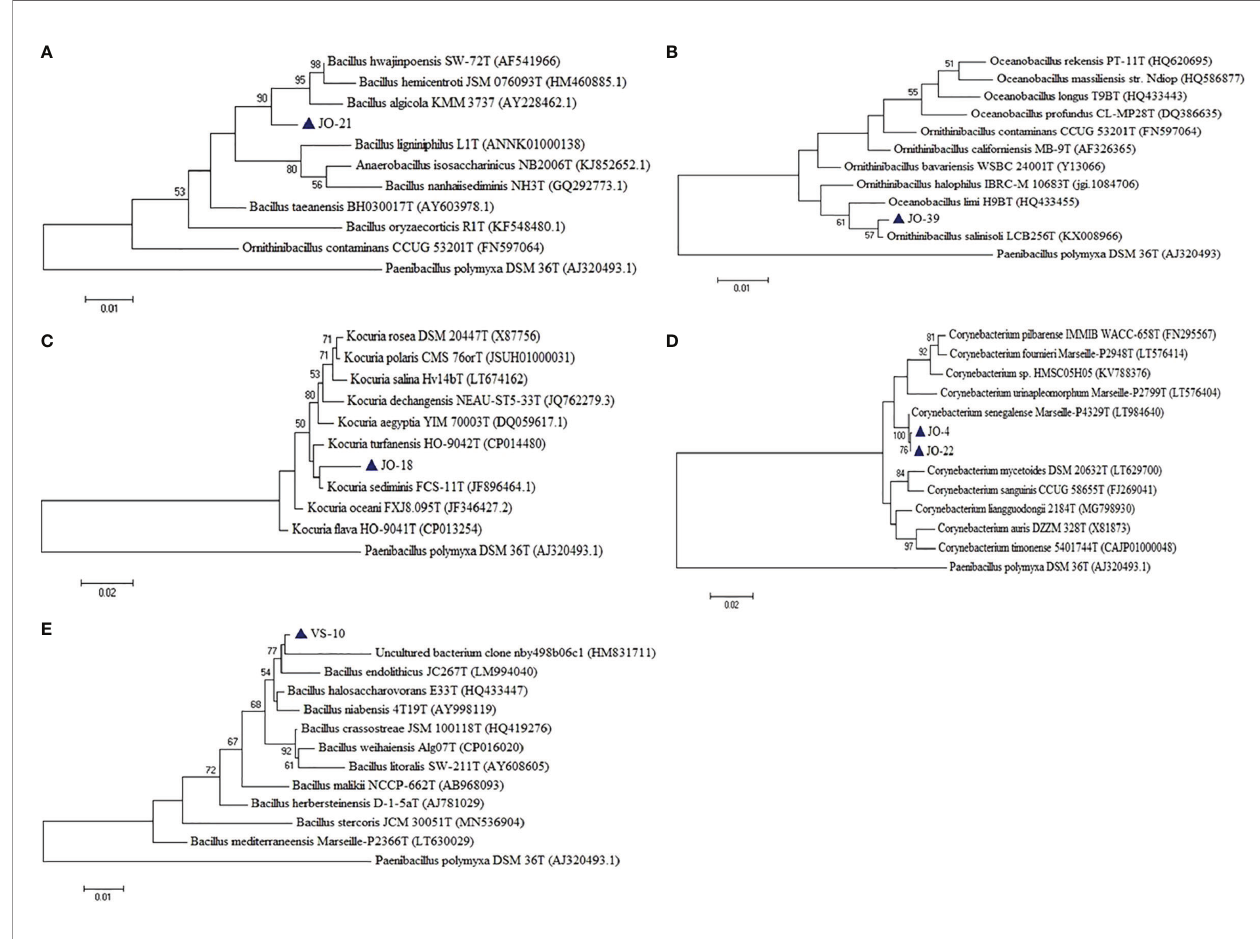
FIGURE 9 | Phylogenetic tree constructed using 16S rRNA gene sequences of putative novel taxa (A) JO-21, (B) JO-39, (C) JO-18 (D) JO-4, and JO-22, (E) VS- 10, and some of their closest phylogenetic relatives. The tree was reconstructed by the Maximum Likelihood method using MEGA 6 software. Paenibacillus polymyxa DSM 36 T was used as an outgroup. The numbers on the tree indicate the percentages of bootstrap sampling derived from 1,000 replications. Blue triangles indicate the strains isolated in this